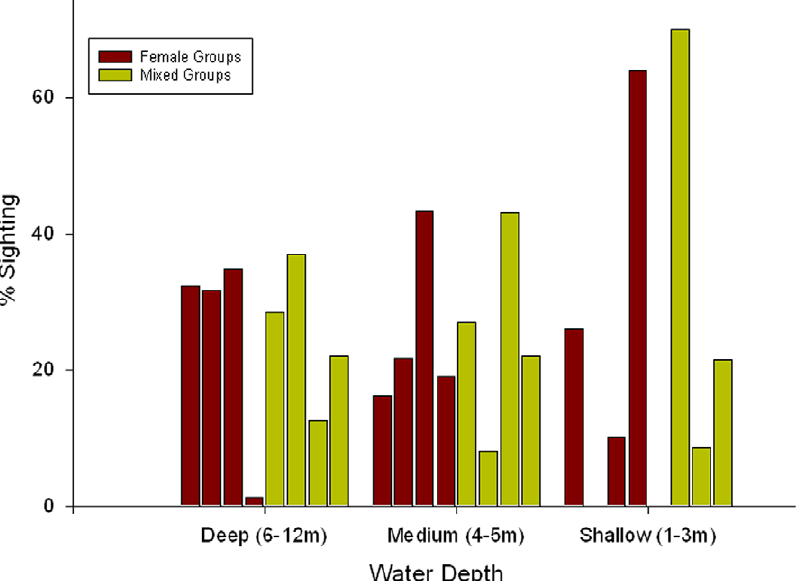
Figure 3. Percentage of dolphin encounters in varying water depths for female and mixed-sex groups in the Clarence River estuary per season. The sum for the four seasons amounts to 100% for each water depth. Seasons are in order Spring, Summer, Autumn and